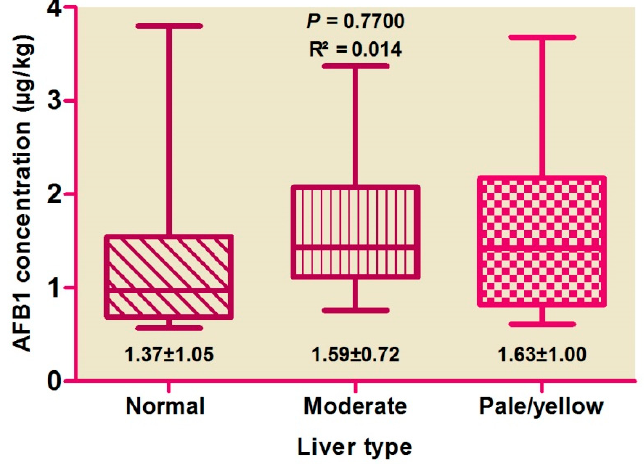
Figure 1. Distribution of aflatoxin B1 concentration between liver types.